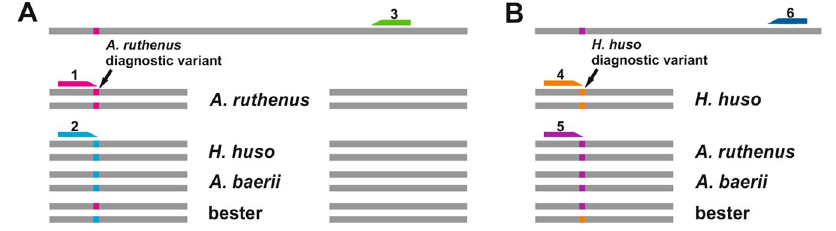
Figure 4. Scheme of read alignment to reference contig of Acipenser ruthenus , diagnostic variants, and designed primers. 1 = A . ruthenus positive primer; 2 = A . ruthenus negative primer; 3 = common primer; 4 = H . huso positive primer; 5 = H . huso negative primer; 6 = common